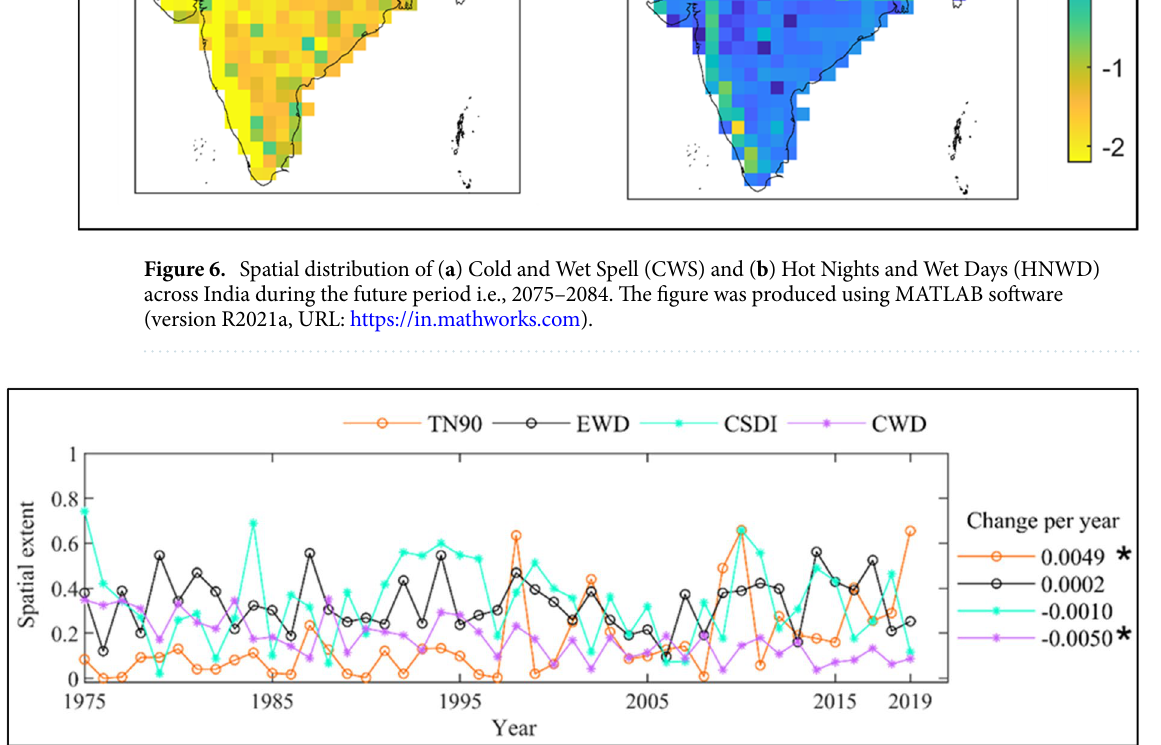
Figure 7. Year-wise variation of areal coverage (in proportion of entire Indian mainland) exhibiting positive Precipitation and Temperature Extreme Indices (PEIs and TEIs): TN90 (Hot Nights), EWD (Extreme Wet Days), CSDI (Cold Spell Duration Index) and CWD (Consecutive Wet Days), during the post-climate regime shift period, i.e. 1975–2019. Rate of changes are shown in the legend and the significant changes (as per M–K test at 5% significance) are noted with star